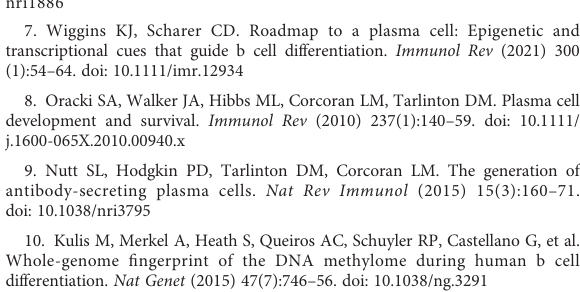
SUPPLEMENTARY TABLE 3 Correlation of survival/proliferation and differentiation